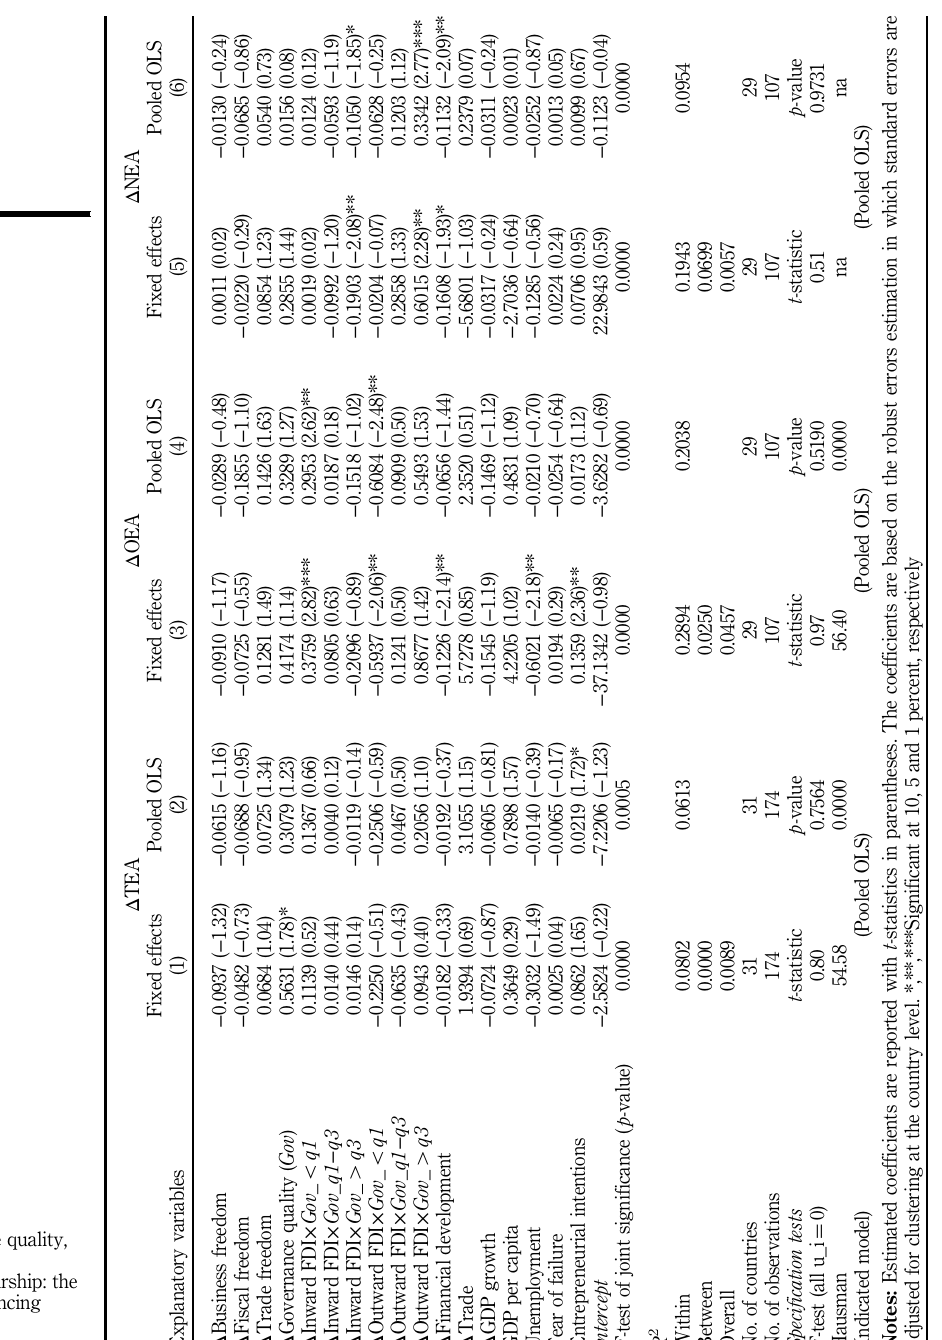
Table VII. Governance quality, FDI and entrepreneurship: the first differencing